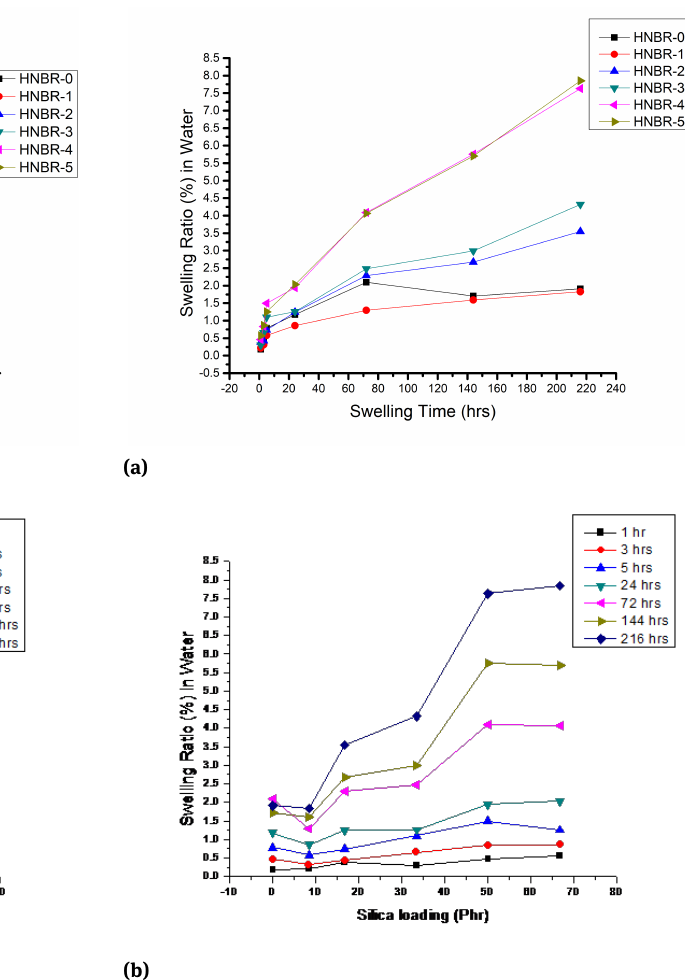
Figure 3: Swelling behavior of HNBR in toluene (a) swelling ratio vs. swelling time (b) Swelling ratio vs. silica concentration